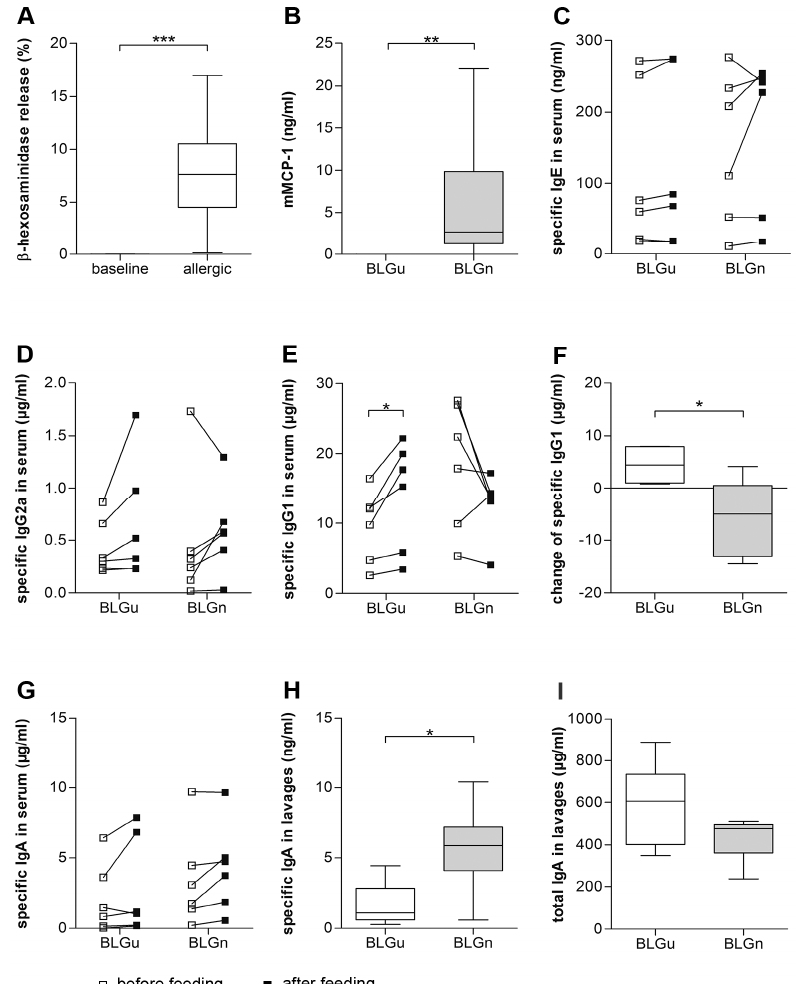
Figure 5. Immune response to gavages in allergic mice. Serum samples collected after sensitization with BLGu and after three oral gavages were analyzed. After randomization into the two experimental groups, baseline values (white squares) did not differ. (BLG specific IgE (unpaired t - test, p = 0.63), IgA (unpaired t -test, p = 0.45), IgG2a (Mann–Whitney-U-test, p = 0.67), and IgG1